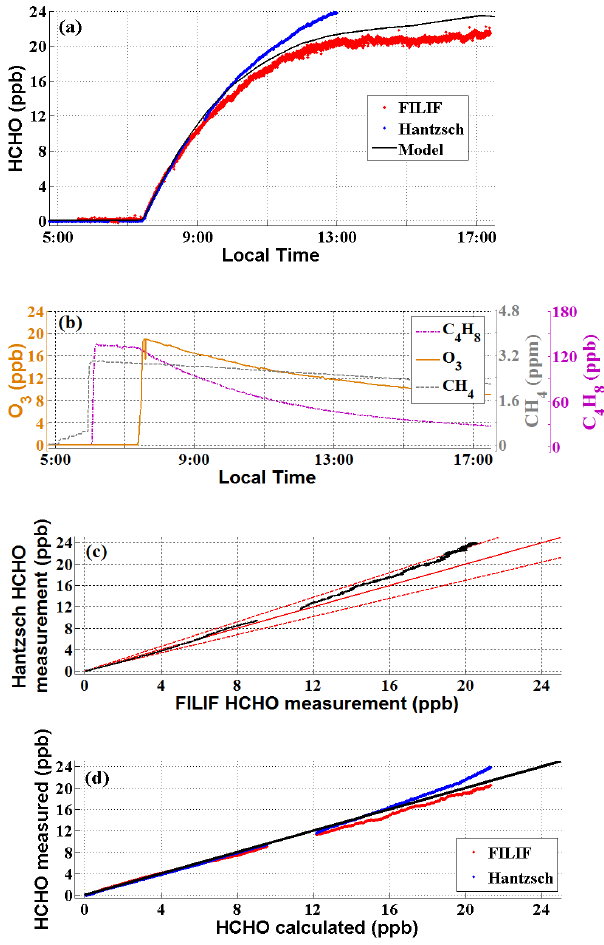
Figure 3. (a) Time series of measured and calculated HCHO mixing ratios during day 3. (b) Time series of C 4 H 8 , ozone, and CH 4 . (c) Comparison between HCHO measurements. Error bars represent 3sigma precision. Lines represent one-to-one agreement and ± 15% FILIF measurements. (d) Measurement/model comparison, with the line showing 1-1 agreement.